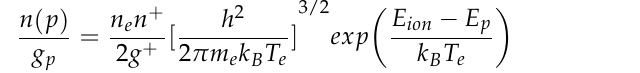
Figure 11. Variations of the rotational temperature with ( a ) different voltages applied on the stationary power electrode at 1 sLm gas flow rate, ( b ) rotational frequencies of the power electrode at 14 kV applied voltage and 1 sLm gas flow rate, and ( c ) gas flow rates at 14 kV applied voltage and 18,000 rpm rotation frequency of the power